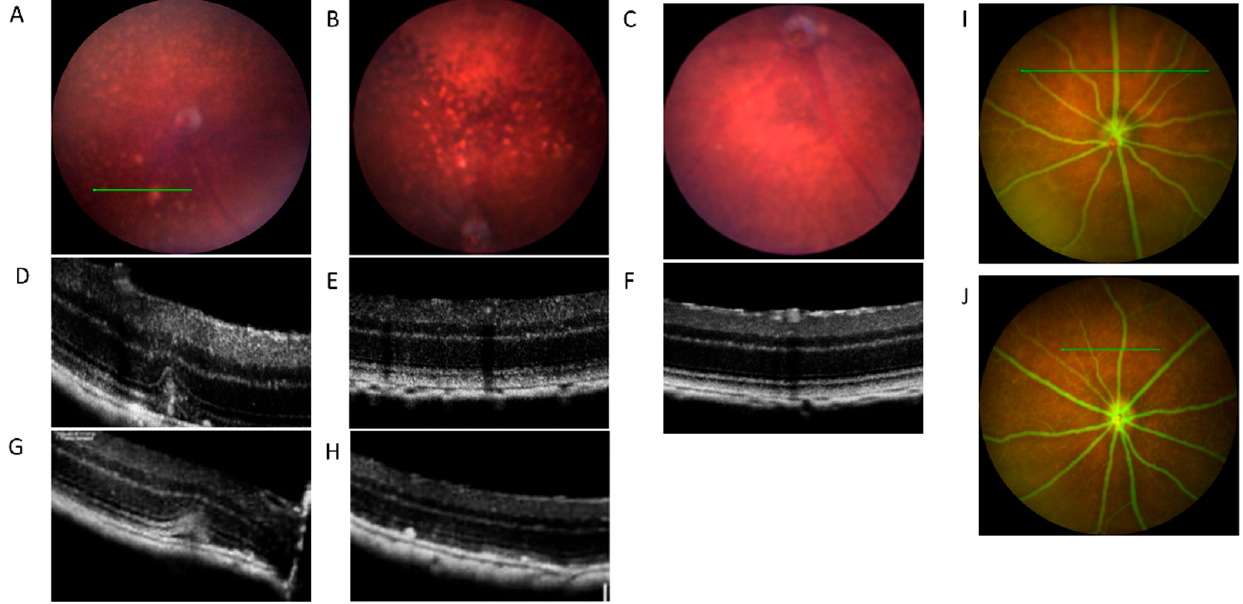
Figure 1. In vivo retinal imaging using combined color photography and OCT retinal imaging compared between CAG-HtrA1 Tg mice and wild-type (20 months). ( A ) CFP from the CAG-HtrA1 Tg mice shows the area of large white lesion accumulation ( B ) Yellow-whitish foci scattered through the retina in the CAG-HtrA1 Tg mice. ( C , F ) CFP and cross-sectional OCT scan from the wild type mice. ( D , G ) Cross-sectional OCT scans show the RPE elevation on OCT corresponding to the large white lesions, indicating the small amount of subretinal fluid. ( E , H ) Cross-sectional OCT showing diffuse irregular reflectivity of the RPE layer and ellipsoid zones ( E ) and some intraretinal hyper- reflective foci ( H ) in the eyes with yellow-whitish foci ( I , J ) No leakage, oozing, or staining from neither of the mice groups noted from the FFA images corresponding the lesion from the fundus.